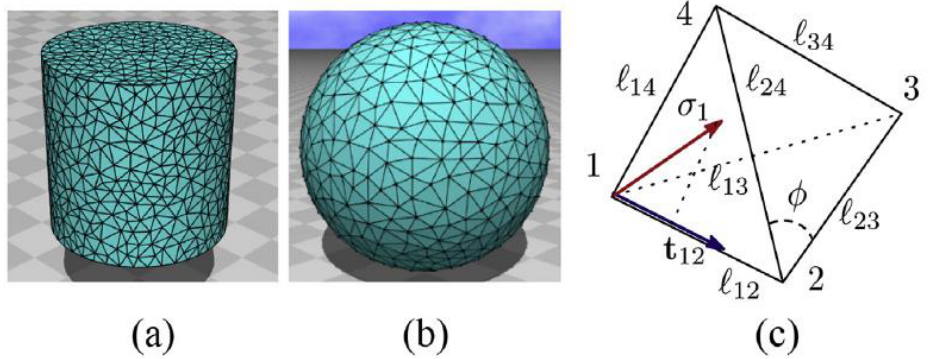
Figure 10. ( a , b ) represent both cylindrical and spherical domains. ( c ) shows how the discrete Hamiltonian is defined on each tetrahedron [90] (Reprinted with permission from [90]).